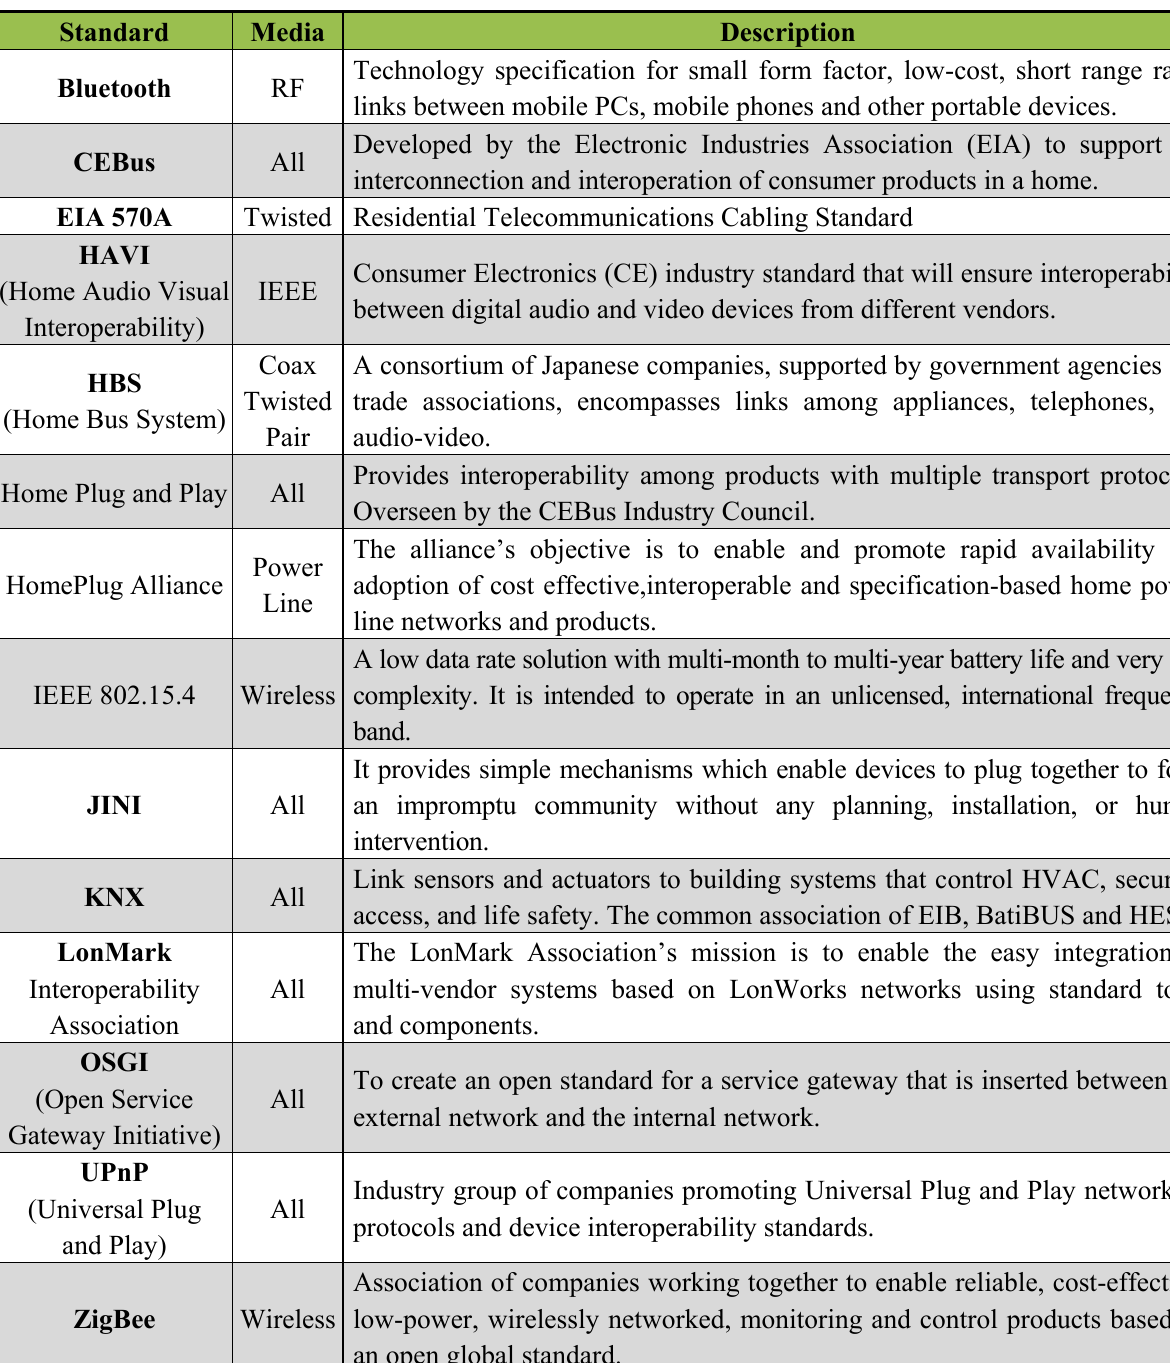
Table 1. Main Domotic Alliances and Working